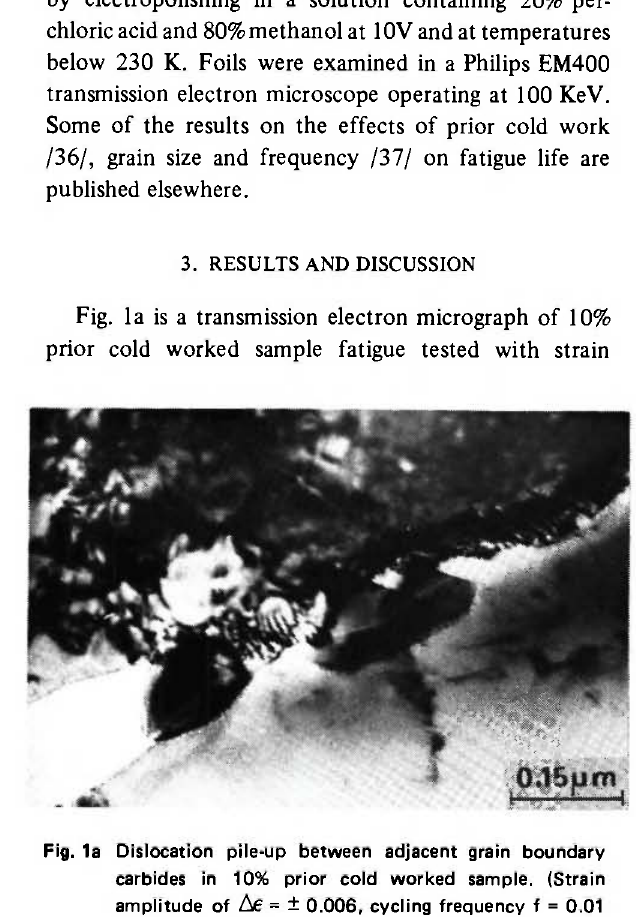
Fig. la Dislocation pile-up between adjacent grain boundary carbides in 10% prior cold worked sample. (Strain amplitude of Δε = ± 0.006, cycling frequency f = 0.01